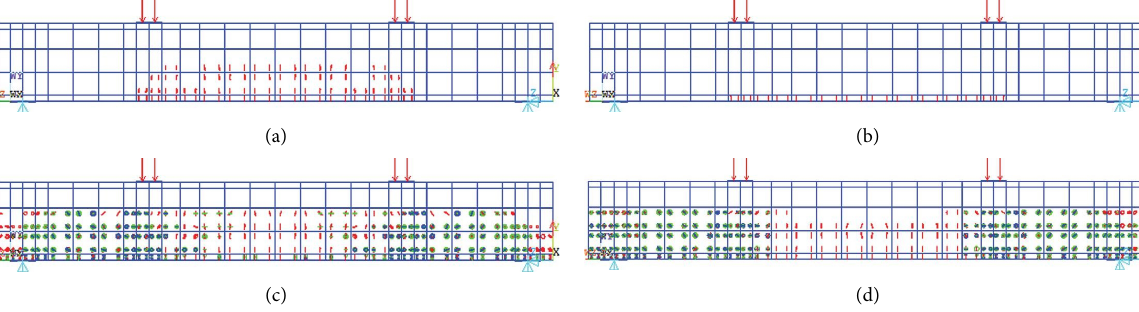
Figure 19: Because of a change in the diameter of the tensile steel bars, beams have begun to crack and have been damaged: (a) cracks begin to appear in the beam ( P crack � 8kN), 2 ϕ 18; (b) cracks begin to appear in the beam ( P crack � 10 kN), 2 ϕ 28; (c) beam beginning to show signs of damage (Pmax � 90kN), 2 ϕ 18; (d) beam beginning to show signs of damage (Pmax � 130kN), 2 ϕ